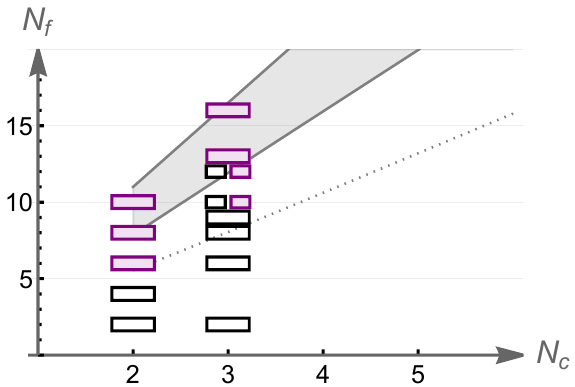
Figure 4. Summary of results for SU( N c ) gauge theory and fundamental representation fermions. The rectangles depict existing lattice result for N c = 2 and N c = 3 and different values of N f . The colored rectangles indicate an observation of an IRFP; see text for more